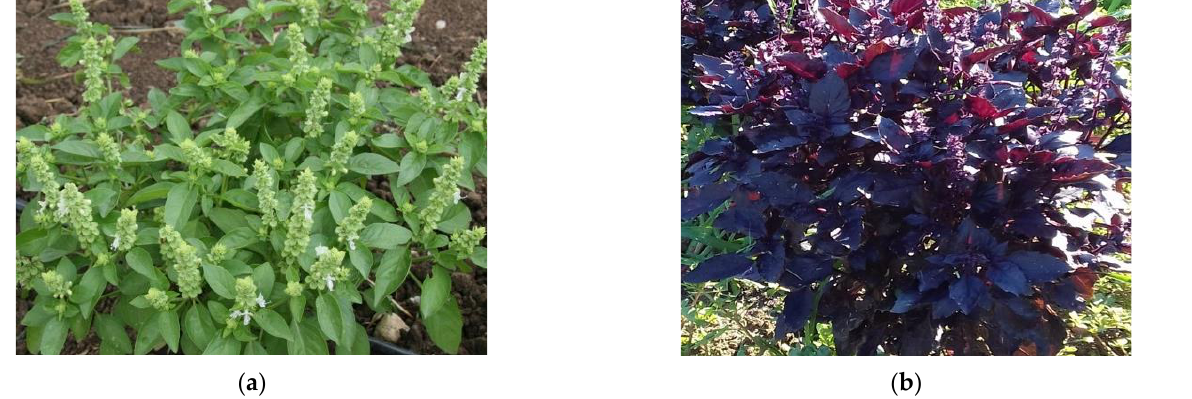
Figure 1. Yellow basil ( Ocimum basilicum L., fam. Lamiaceae ), “ Aromat de Buzau ” variety ( a ) and Red-violet basil ( Ocimum basilicum var. purpurascens L., fam. Lamiaceae ), “ Serafim ” variety ( b ). Red-violet basil ( Ocimum basilicum var. purpurascens L., fam. Lamiaceae ), “ Serafim ” variety (Certificate no. 4432/2017), semi-early variety of violet-purple color, intense, due to the high content of anthocyanins, a variety resistant to specific diseases and pests (Figure